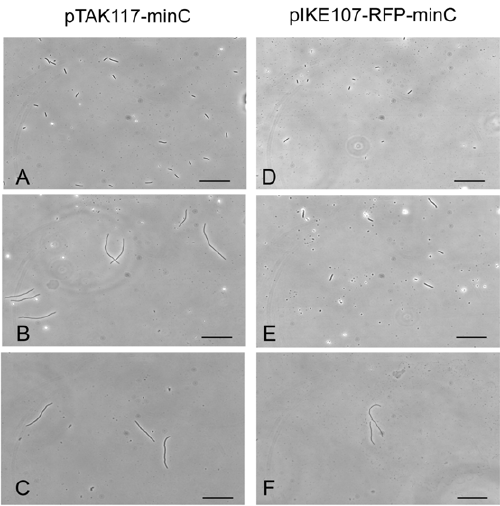
Figure 5. Comparative behavior of the IPTG- and aTc-sensitive time stamp devices. Visible light images of PB103:pTAK117-minC and PB103:pIKE107-RFP-minC upon continuous exposure to 2 mM IPTG and 1 nM anhydrotetracycline, respectively. Overnight cultures (initiated from glycerol stocks and grown at 37 u C in LB amp50) were sub-cultured to fresh LB amp50 for 90 min and used at a 100-fold dilution